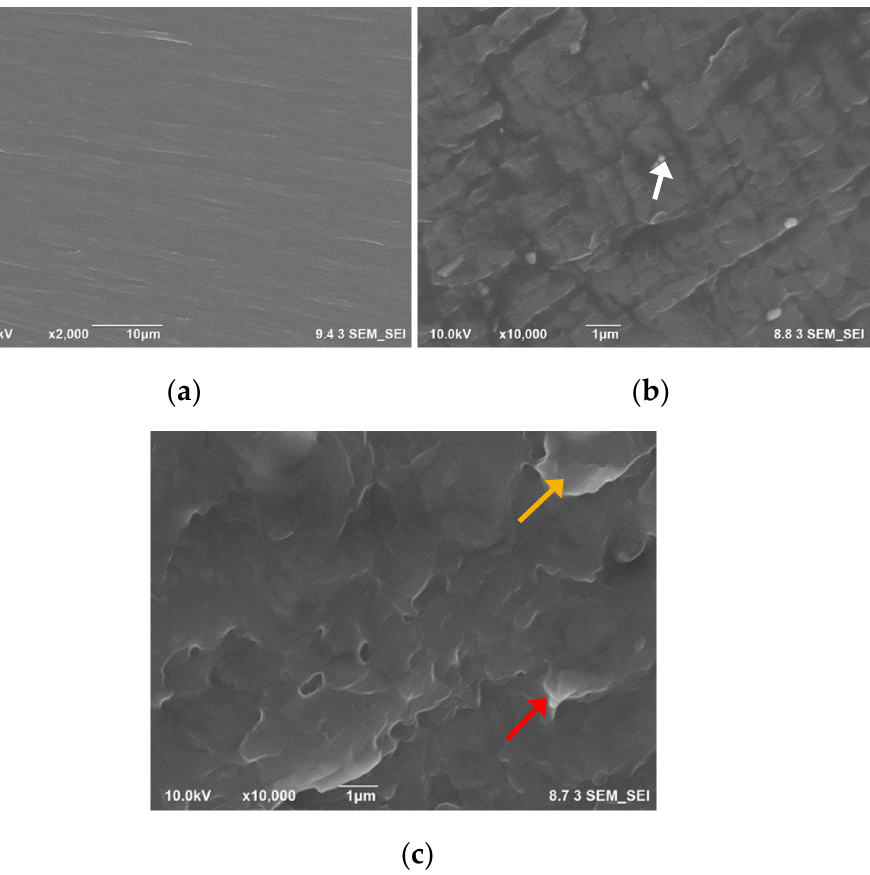
Figure 1. FESEM morphology of the fracture surface of tensile samples: ( a ) the smooth surface of pure PVA, ( b ) good dispersion of individual filler (white arrow), and ( c ) a looped filler (red arrow) and a beach mark (brown arrow) on the PVA/ZnO/GCNF biocomposite film surface.